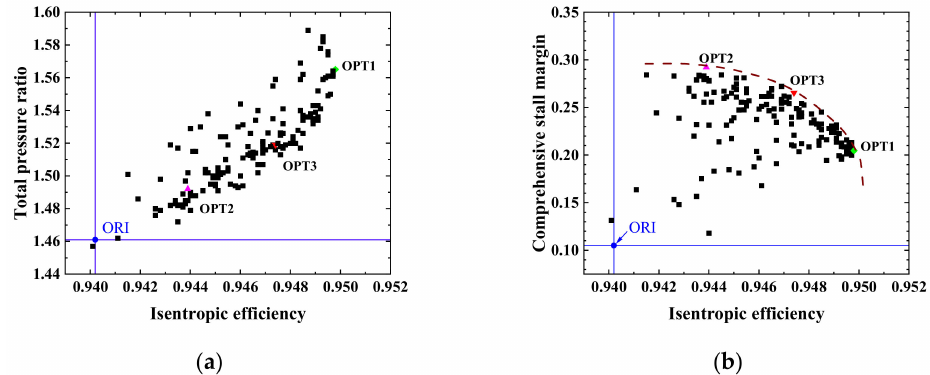
Figure 8. Distributions of optimized sample points and Pareto front: ( a ) isentropic efficiency—total pressure ratio; ( b ) isentropic efficiency—comprehensive stall margin.